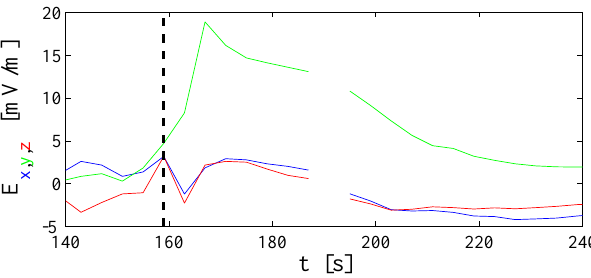
Figure 9. Electric field measured by the EFW instrument on Fig. 9. Electric field measured by the EFW instrument on the Cluster 1 spacecraft after the first plasmoid the Cluster 1 spacecraft after the first plasmoid observation on 15 March. The timescale is the same as that in Fig. 6. The dashed observation on 15 March. The time scale is the same as that in Fig. 6. The dashed line at t = 159s marks the line at t = 159 s marks the end of the end of the plasmoid.